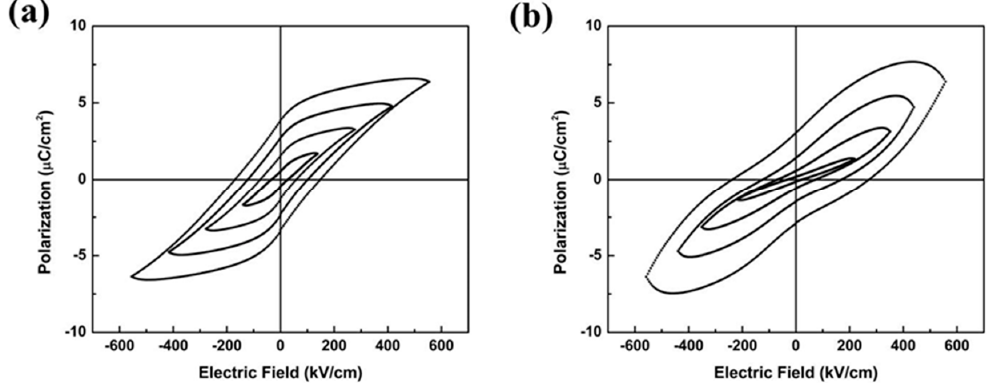
Figure 3. Hysteresis loops for the ( a ) 0.82KNN-0.18AN film; and ( b ) KNN film.